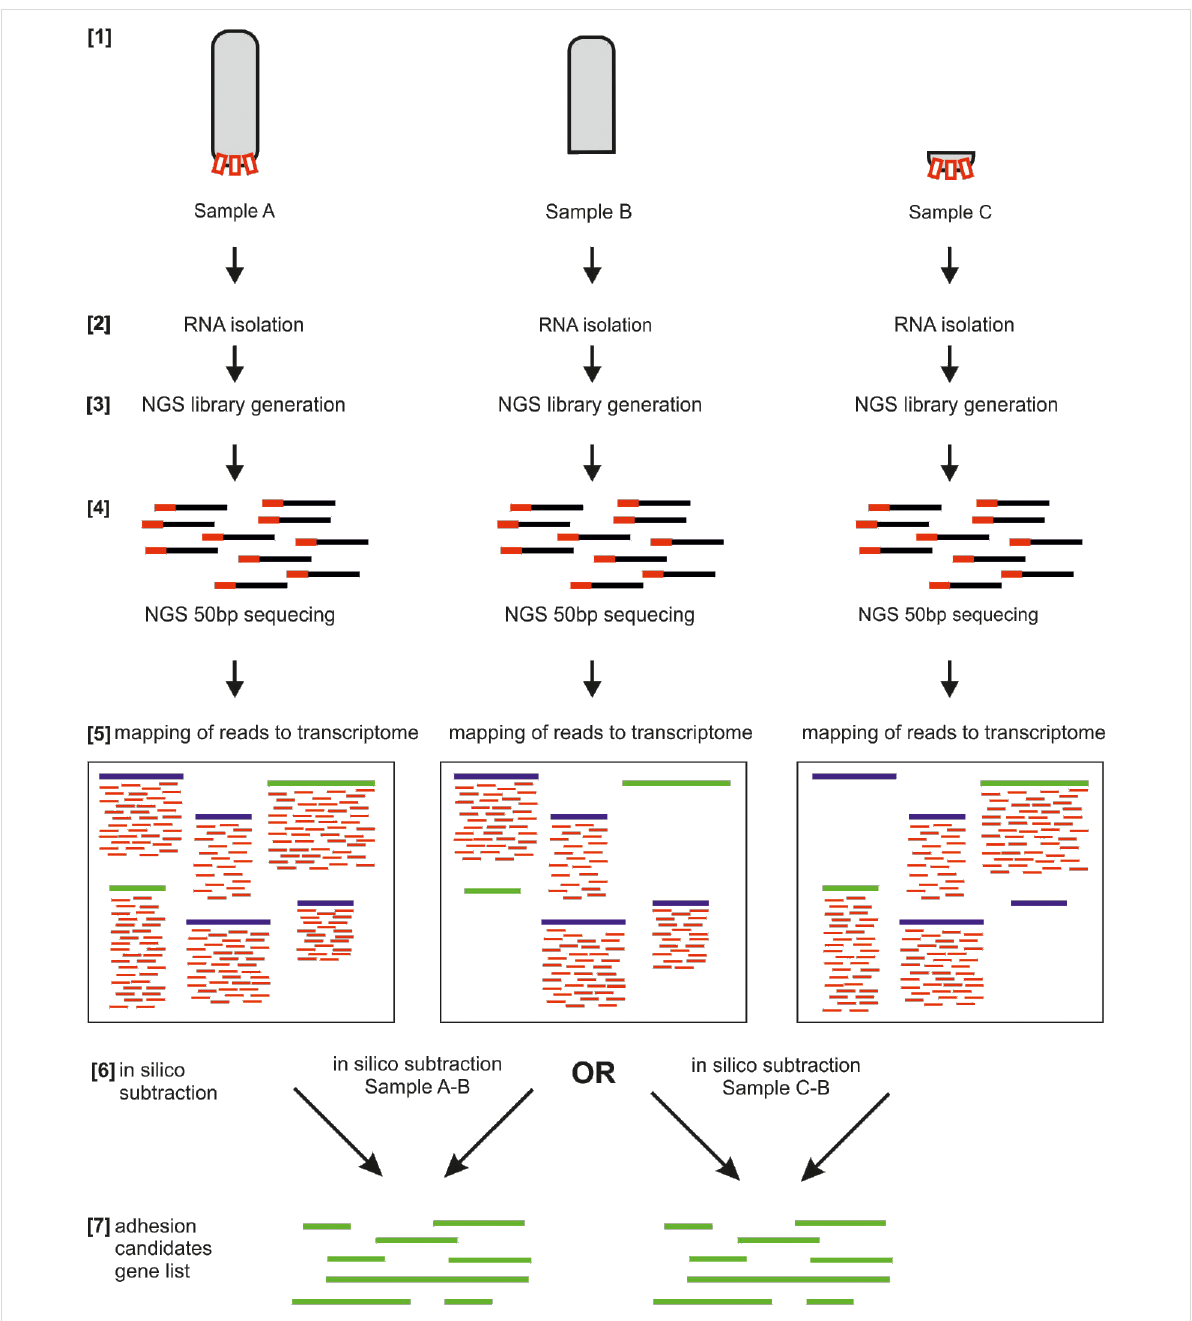
Figure 3: Generation of a differential transcriptome for obtaining a collection of candidate transcript enriched for adhesion-related transcripts. Note that "Sample A" (containing all cells including adhesives cells) minus "Sample B" as well as "Sample C" minus "Sample B" results in an adhesion- enriched candidate transcript list. For small organisms "Sample C" can be difficult to obtain. Therefore, the in silico subtraction of "Sample A" minus "Sample B" is a good option since tissue lacking adhesive organs might be easier to collect. Red rectangles in sample A and C illustrate the adhesive organs in a hypothetical organism. See text for